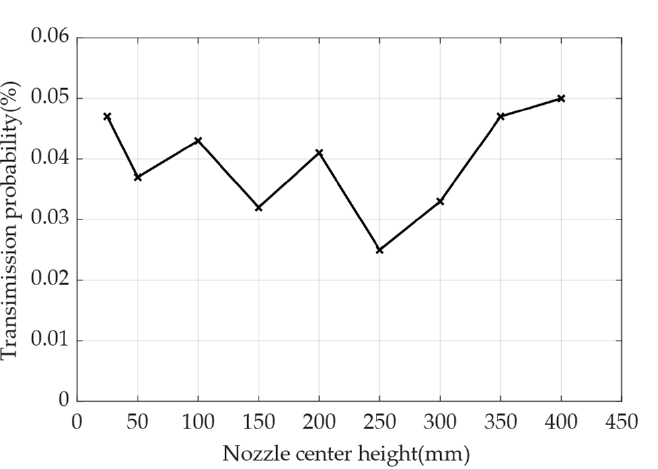
Figure 14. Relationship between nozzle center height and transmission probability. The simulation results are indicated by x-marks in the line graph. The x-axis represents the nozzle center height, as shown in Figure 5c, which is the location of the nozzle. The y-axis represents the transmission probability, which is the ratio of the number of particles received at the sensor sampling port to the total number of particles.